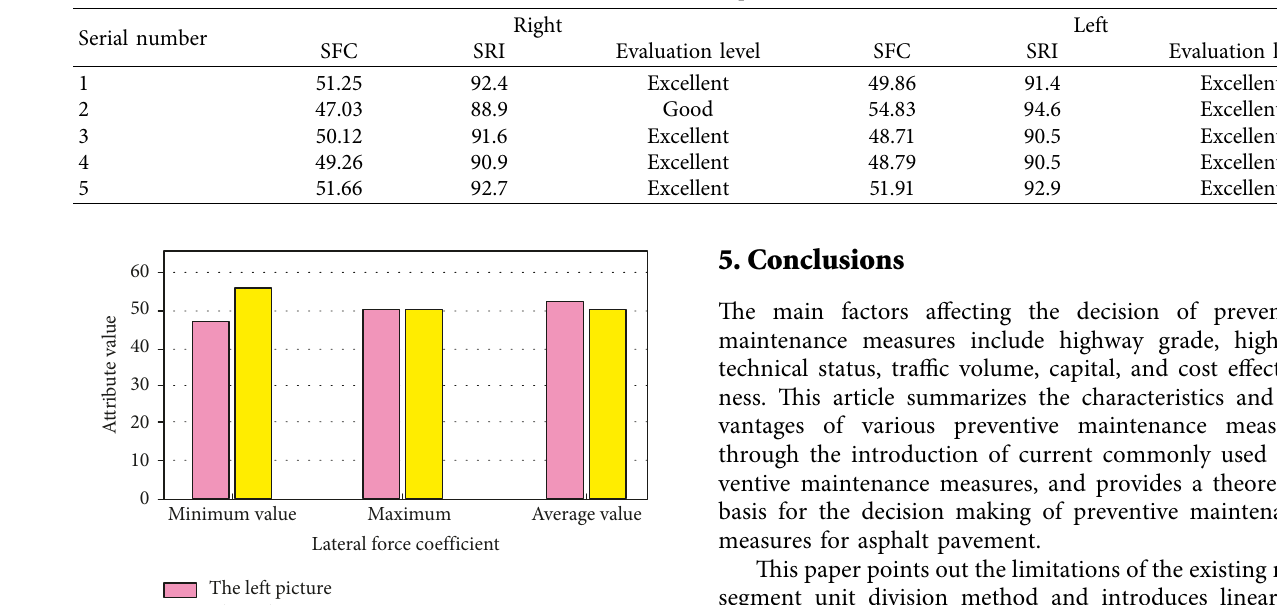
Table 2: Pavement antiskid performance index.